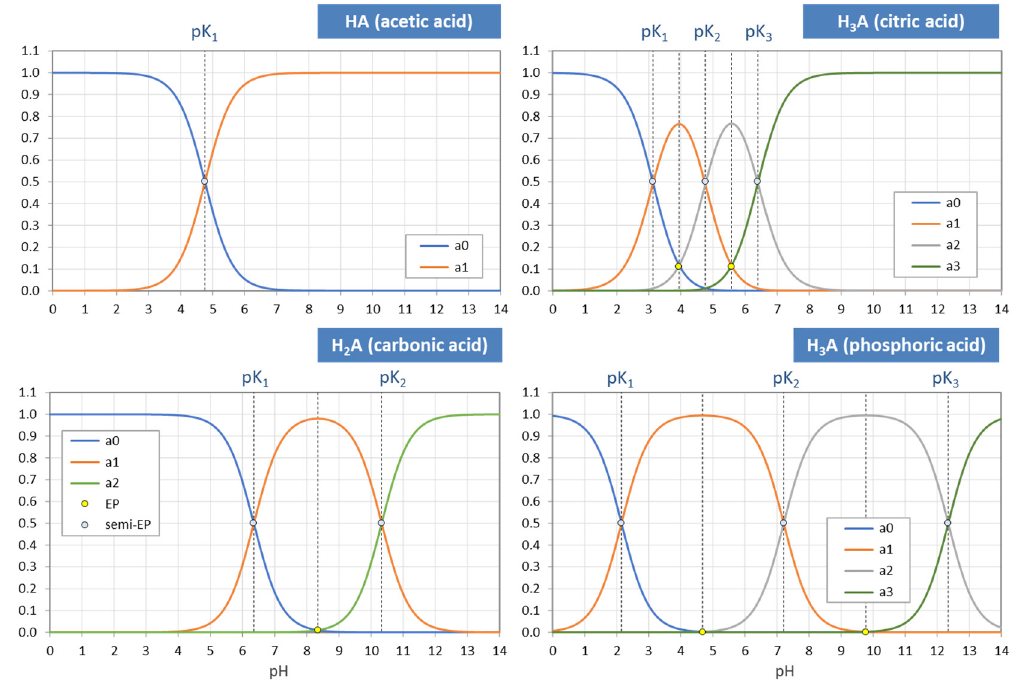
Figure 3. pH dependence of ionization fractions for four acids (small circles mark equivalence points).